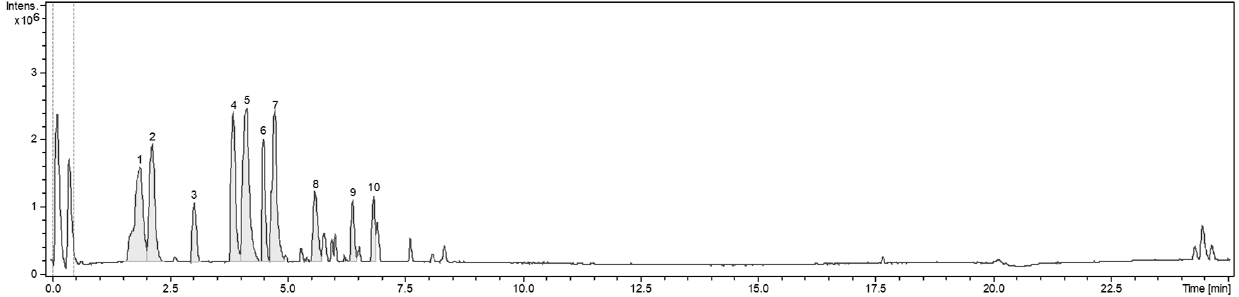
Figure 5. The base peak chromatogram (BPC) of the extract of strain WHA3 T .